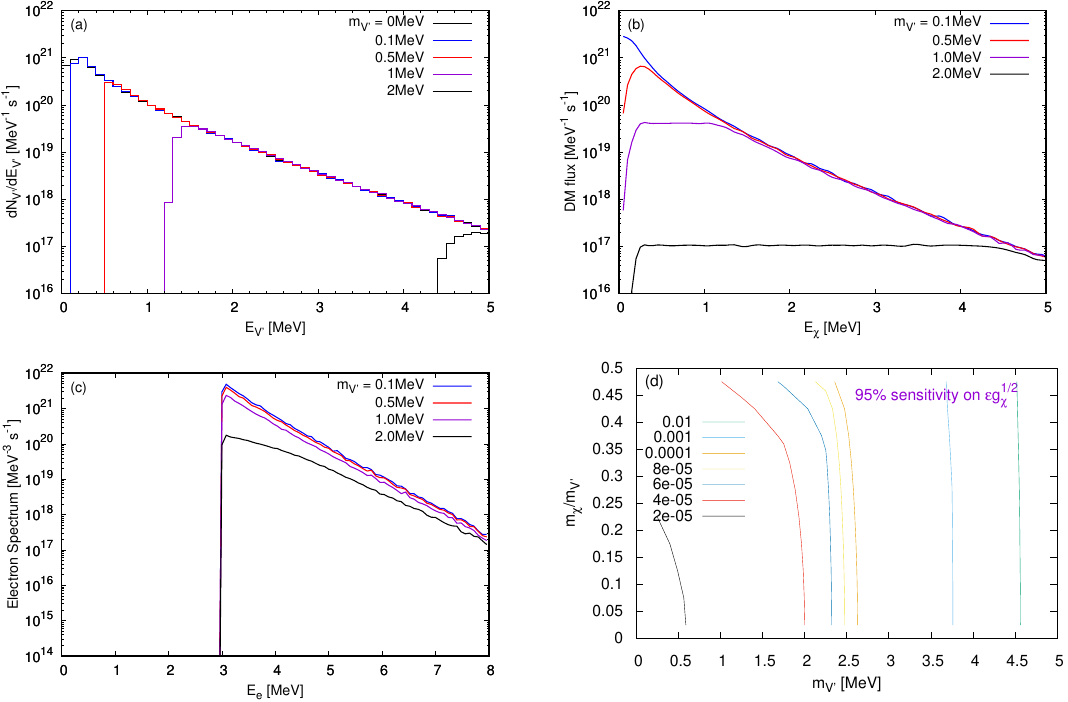
Figure 1 . The V 0 (cid:13)ux (a), the DM (cid:31) (cid:13)ux (b), and the detected electron spectrum (c) from Compton-like scattering of prompt (cid:13) on electrons with 1 GW of thermal reactor power. For illus- tration we take m V 0 = 0 : 1 ; 0 : 5 ; 1 ; 2 MeV, m (cid:31) = 0, the (cid:13) - V 0 mixing (cid:15) = 1, and the dark sector gauge coupling g 0 = 1 in (a), (b), and (c). The subplot (d) shows the sensitivity on (cid:15)g (cid:31) for m V 0 > 2 m (cid:31)